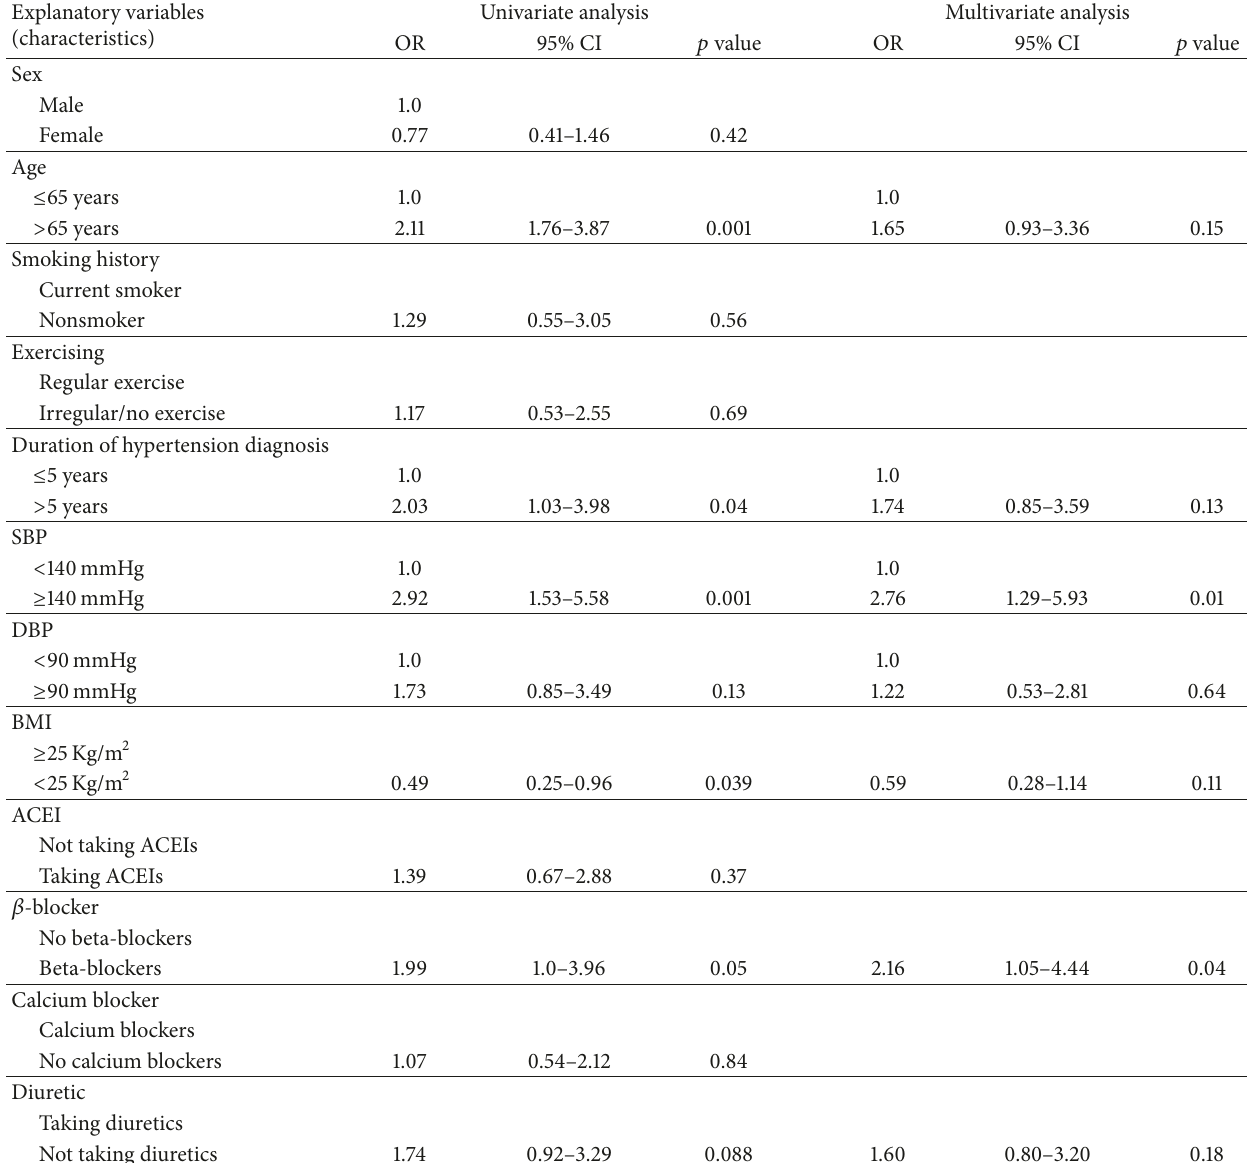
Table 3: Logistic regression analysis of factors associated with target organ